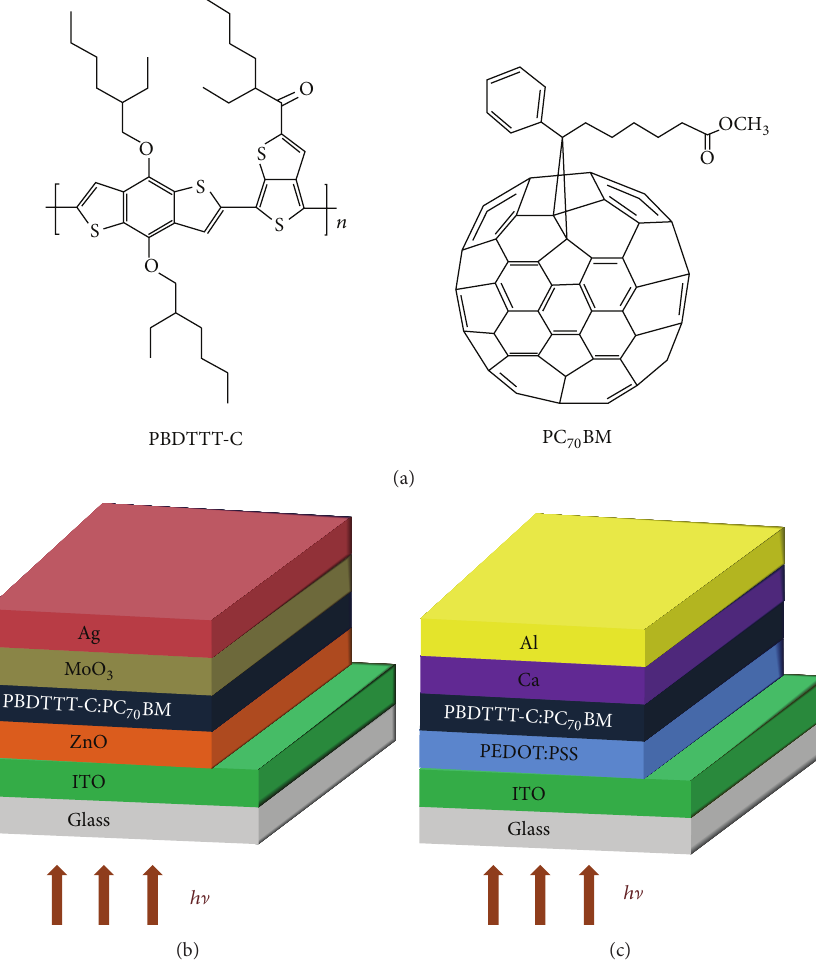
Figure 1: (a) Molecular structures of PBDTTT-C and PC 70 BM. (b) The structure of the inverted polymer solar cell. (c) The structure of the conventional polymer solar